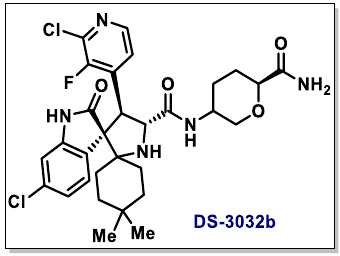
Figure 7. Structure of DS-3032b, a MDM2 inhibitor.